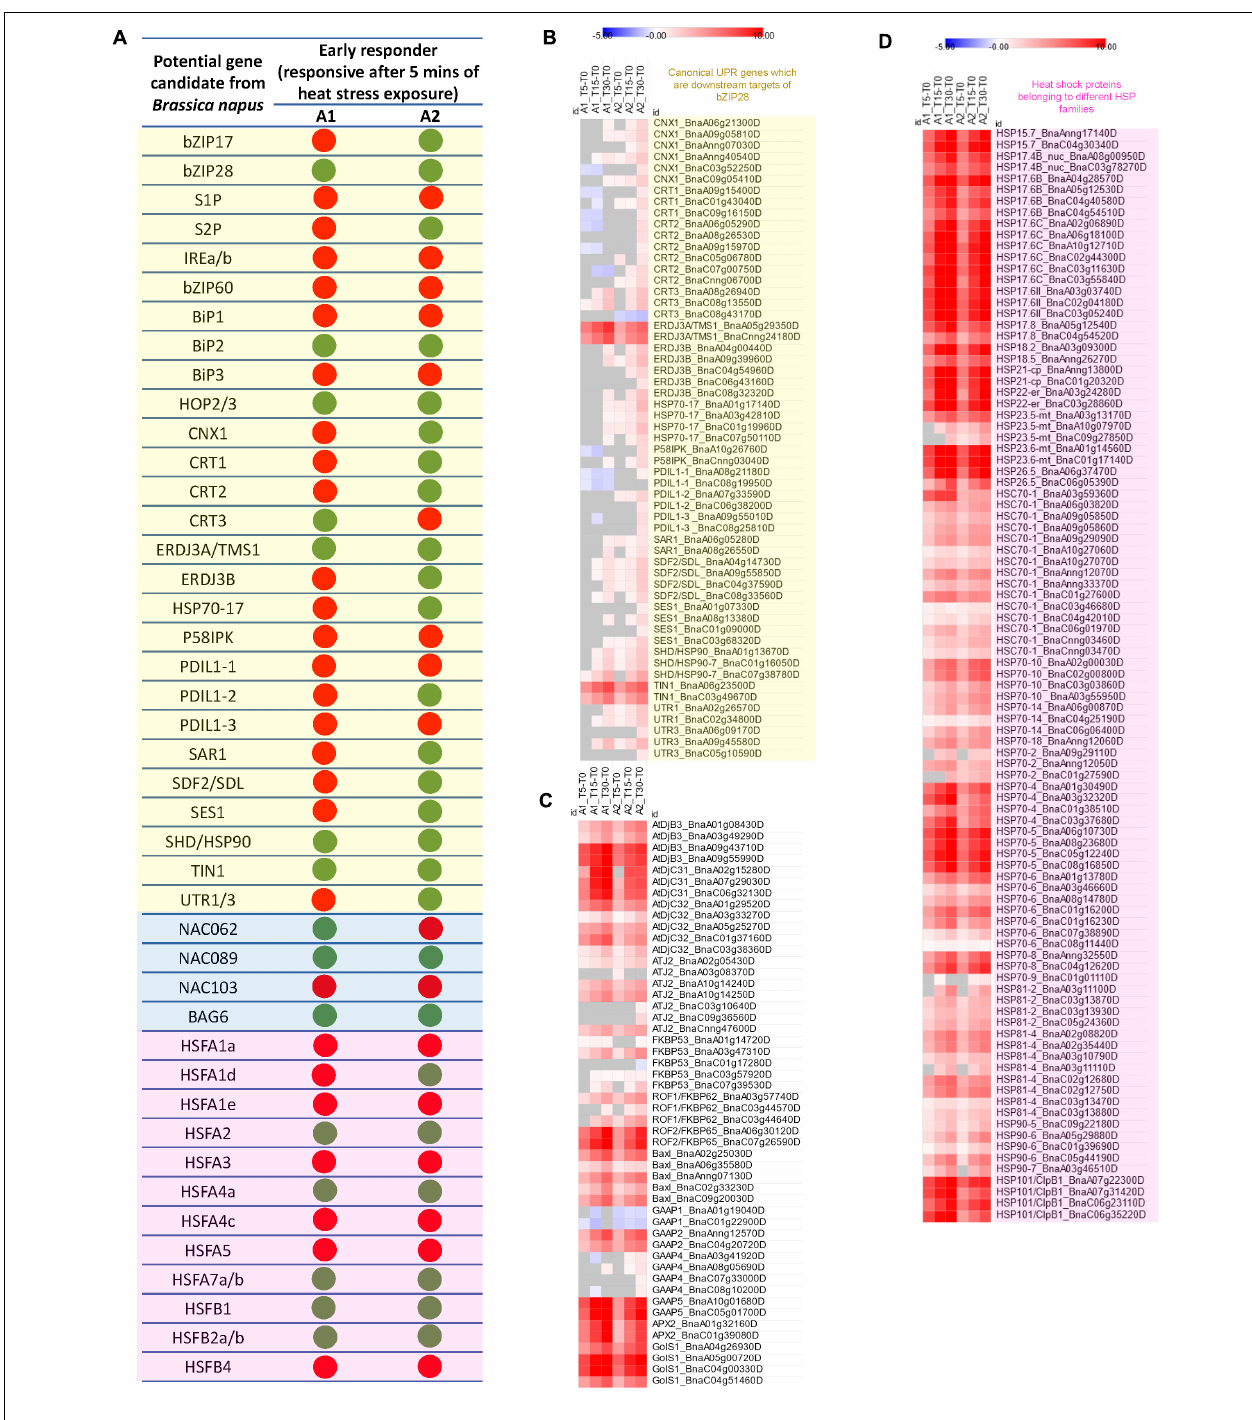
FIGURE 2 | (A) Early heat stress-responsive genes involved in the regulation of UPR (transcripts regulating the two arms of the unfolded protein response in ER, i.e., the bZIP28/17 mediated pathway and the bZIP60-IREa/b mediated pathway as well as canonical ER-UPR genes which are downstream targets of bZIP28 ; light yellow box ) in ER, ER-UPR associated NAC TFs and their selected targets ( light blue box ) and cytoplasm (HSFs; light magenta box ) in anthers containing microspore mother cells (A1) and anthers containing uninucleate microspores (A2) subjected to heat stress for 5 min. The green dot represents the 5 min of heat stress-induced change in expression of the gene, and the red dot represents no significant change in gene expression after 5 min of heat stress (Note: The potential gene candidate in B. napus was identified as an early heat stress-responsive gene if even one of the gene homologs displayed a significant change in expression, adjusted p -value < 0.01). Heatmaps showing the Log 2 fold changes in transcript expression of (B) Canonical UPR genes which are downstream targets of bZIP28 ( light yellow box ), (C) foldases, co-chaperones, BAX Inhibitor-1 ( BAXI-1 ), Golgi-apoptotic proteins ( GAAPs ), Galactinol synthase1 ( GolS1 ) and Ascorbate peroxidase2 ( APX2 ), and (D) heat shock proteins belonging to different HSP families ( light magenta box ).